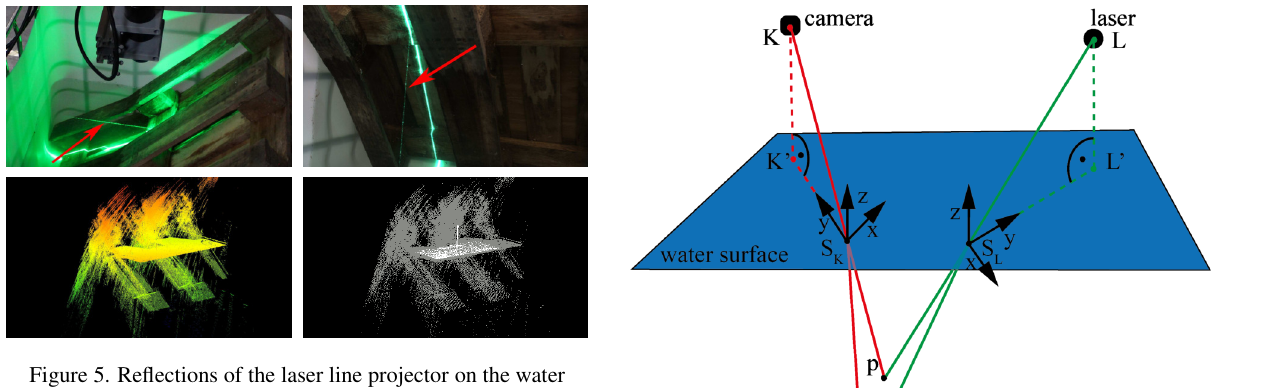
Figure 5. Reflections of the laser line projector on the water surface can be exploited to estimate the water plane.